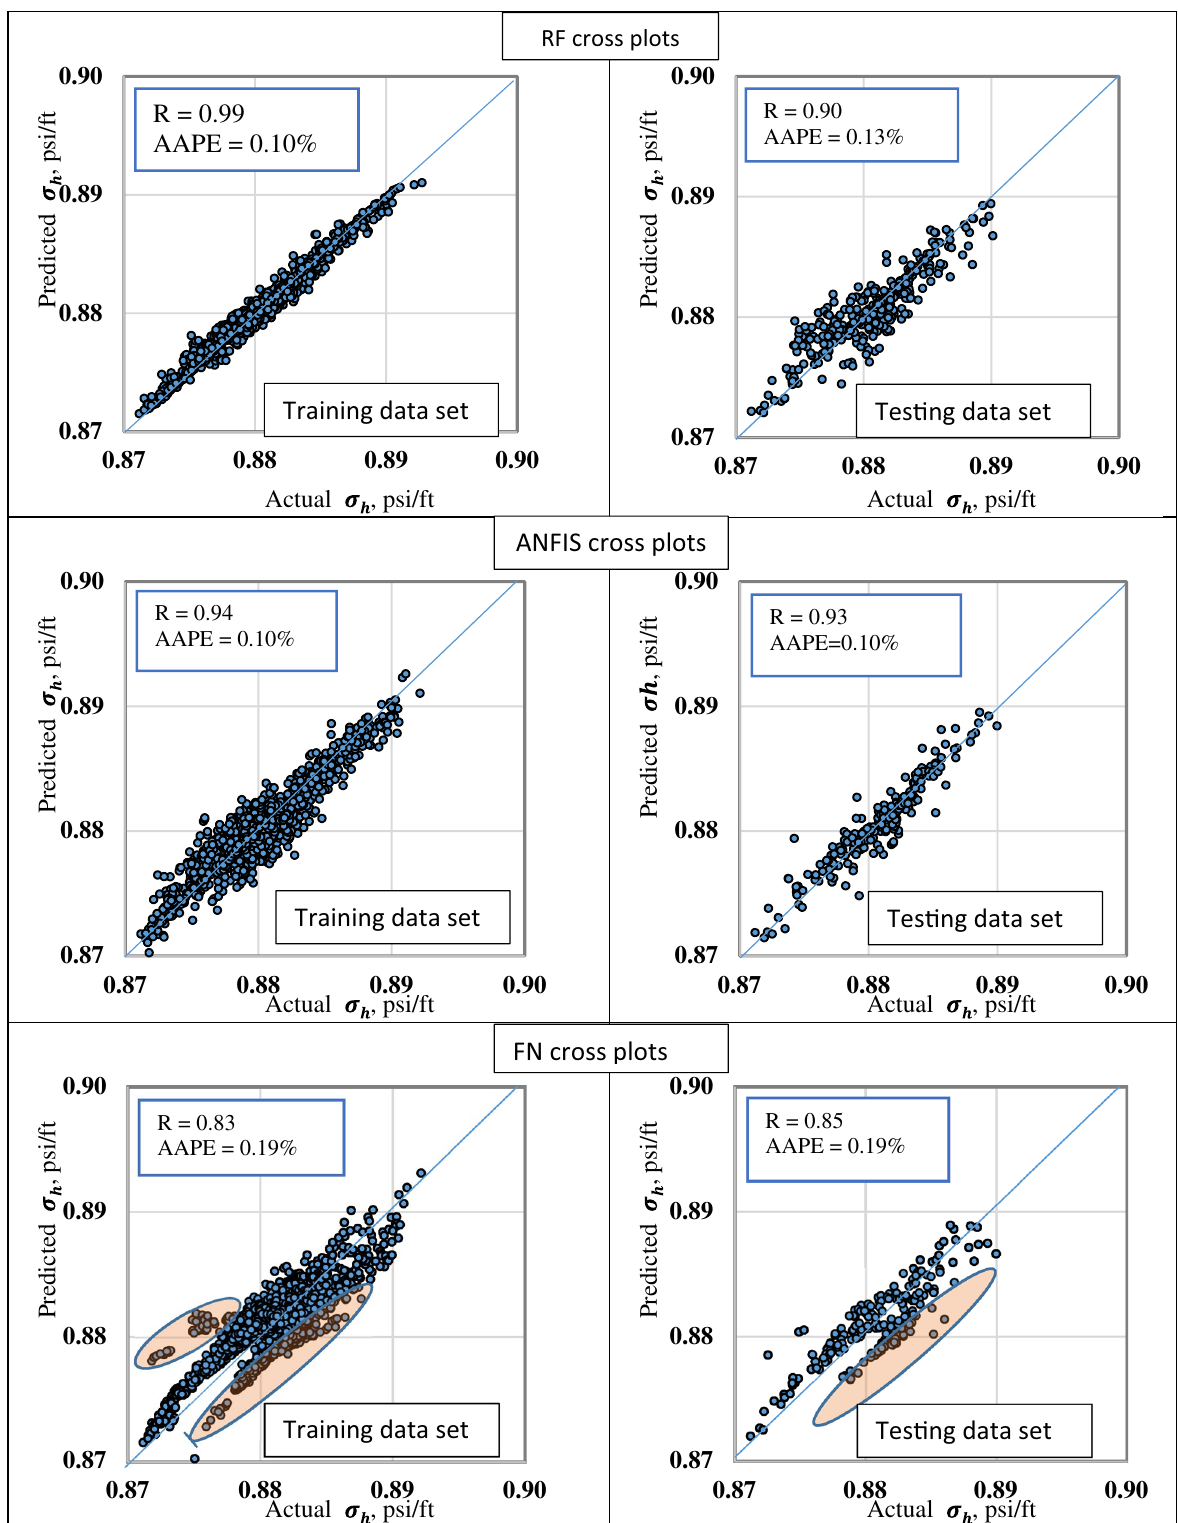
Figure 5. Cross plots of the actual versus the predicted σ h for the training and the testing datasets from RF, FN, and ANFIS